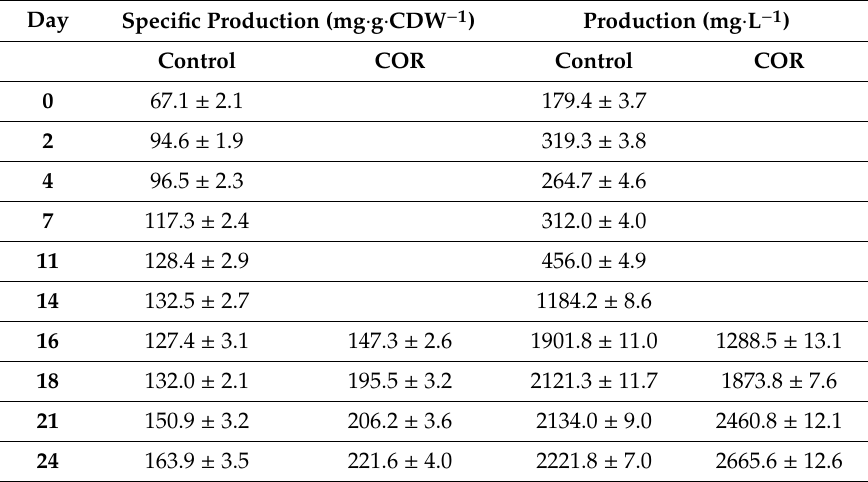
Table 1. Time courses of rosmarinic acid (RA) production expressed as mg · g · CDW − 1 and mg · L − 1 in S. khuzistanica suspension cultures elicited with pre-optimized coronatine (COR) (1 µ M), up to 10 days after inoculation. Each result is the average of 3 replicates ±